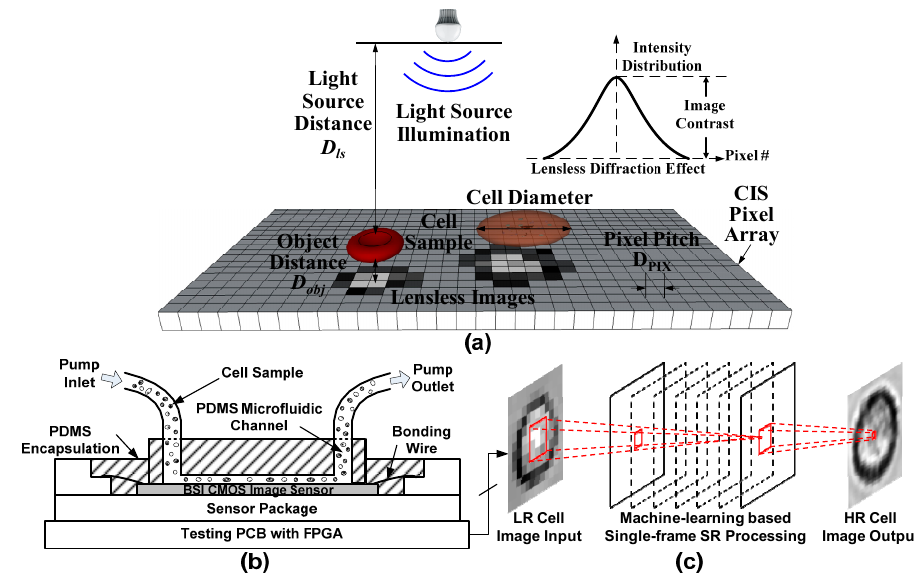
Figure 1. General lensless cell counting system setup based on CMOS image sensor (CIS). ( a ) lensless cell imaging principle; ( b ) cross-sectional view of the lensless system; and ( c ) concept of the machine-learning based single-frame super-resolution (SR) processing.